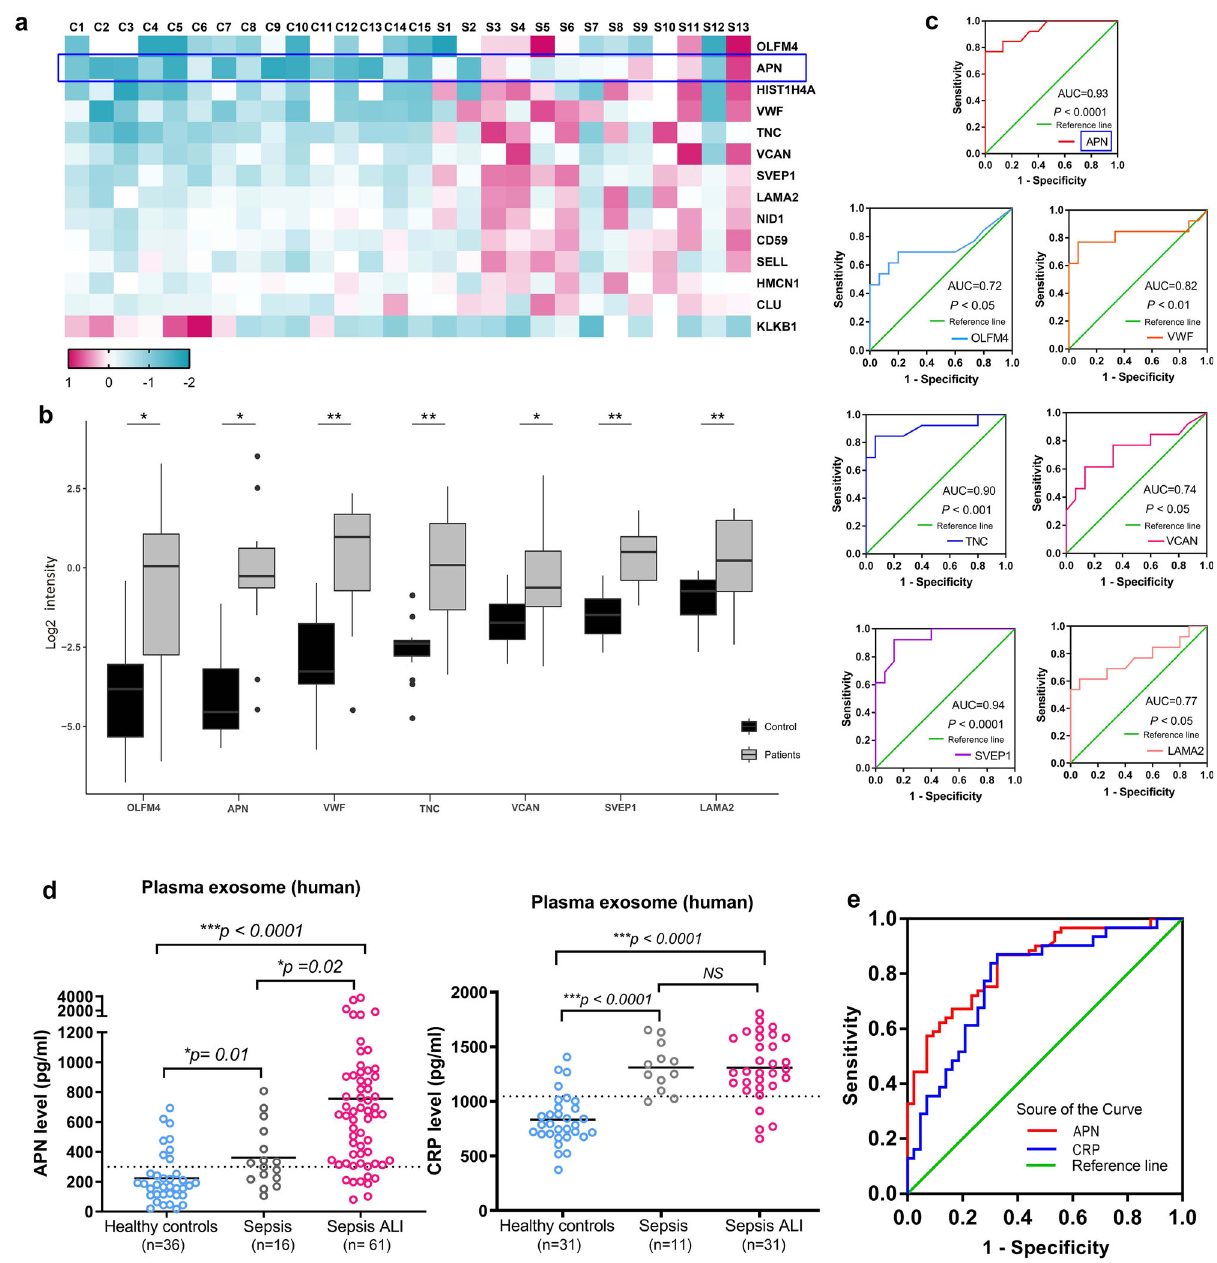
Fig. 2 PRM and ELISA veri fi cation of the top candidates for differentially expressed proteins. a Heatmap display showing 14 differentially expressed proteins from each group of the independent samples. b Using PRM, a box plot depicts the log2 sum fragment area of discovered peptides from seven targeted proteins. * P < 0.05, ** P < 0.01. c The Log2 summed intensity values for peptides identi fi ed with PRM for each speci fi ed protein were used in ROC analysis to compare the patients to the controls. d Compared with individuals in healthy control and sepsis patients, plasma exosomal APN and CRP were expressively enhanced in patients with sepsis-induced ALI ( P < 0.0001). e According to the ROC curve of plasma exosome biomarkers, APN has a signi fi cant predictive ability of sepsis-induced ALI: AUC APN > AUC CRP (0.839 vs. 0.781). ROC, receiver operating characteristic. AUC, area under the curve.